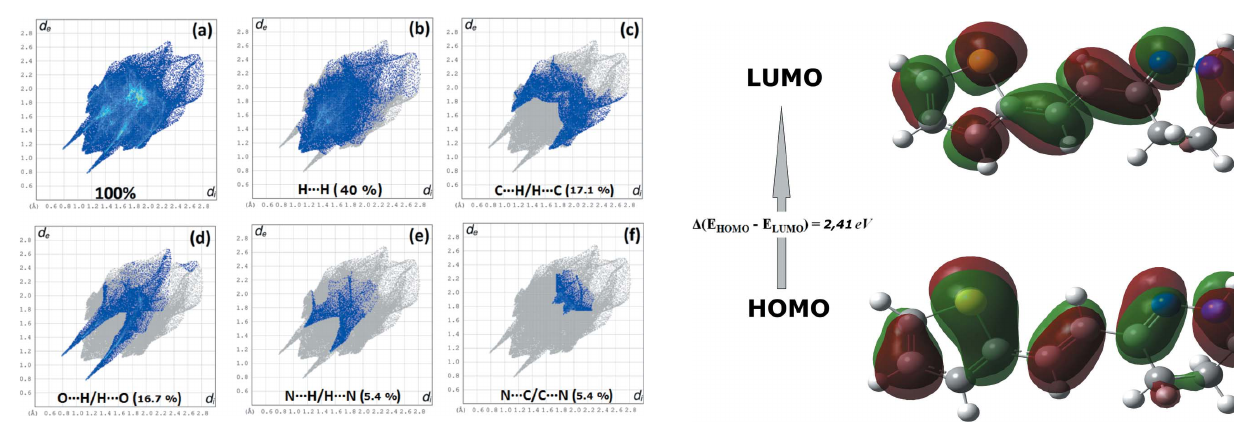
Figure 6 The electron distribution of the HOMO and LUMO energy gaps of the title compound.